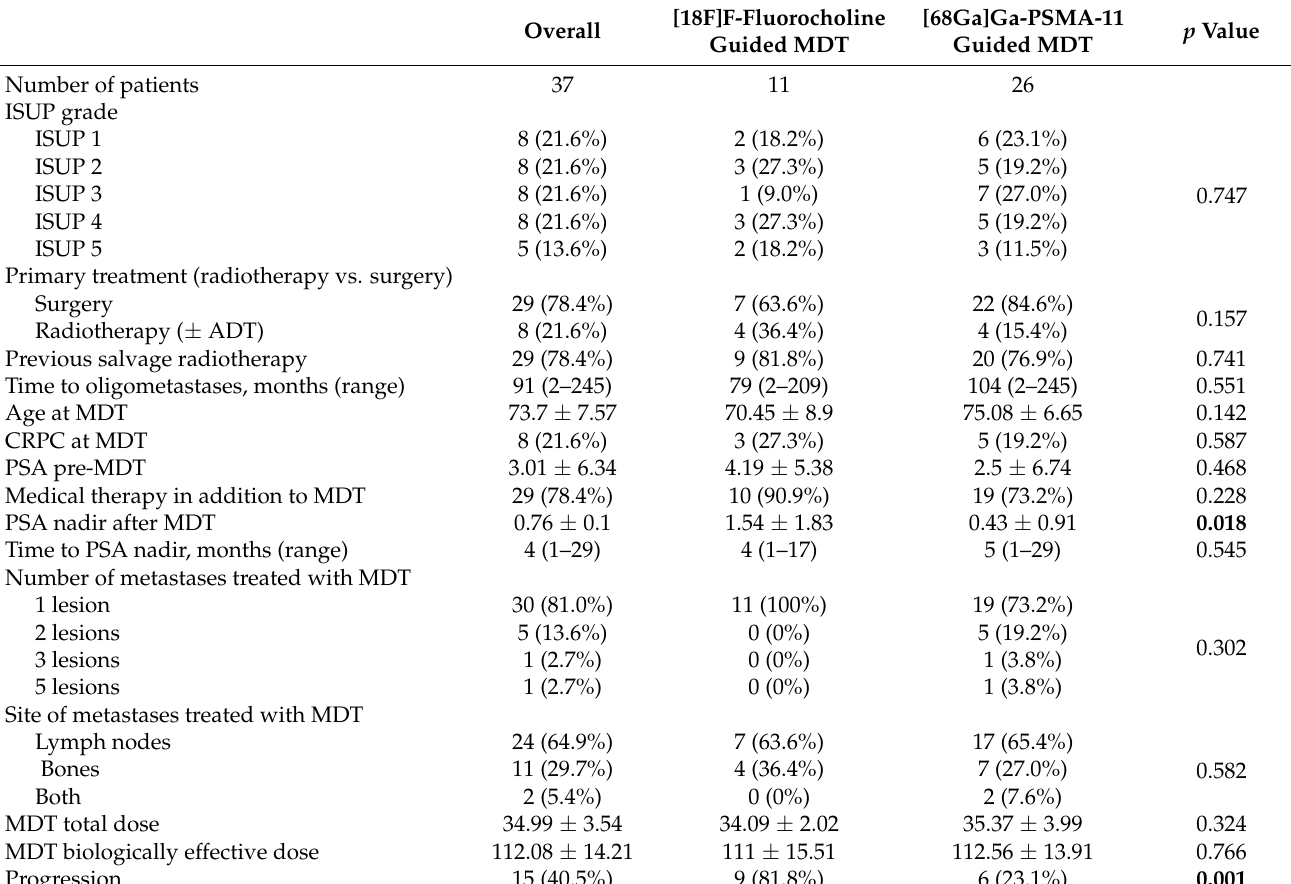
Table 1. Clinical characteristics of patients enrolled at the time of